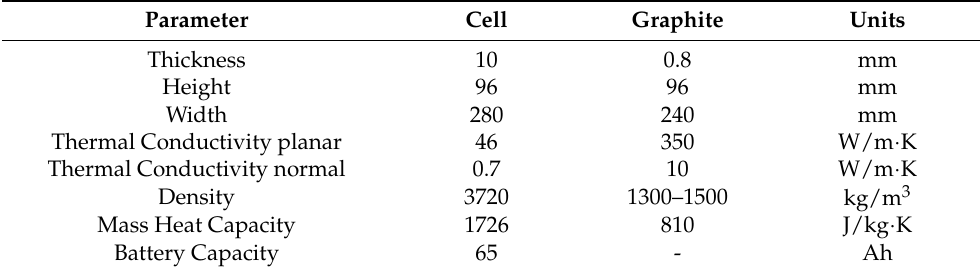
Table 2. Cells and graphite geometrical specifications and physical properties used in the LPM models.